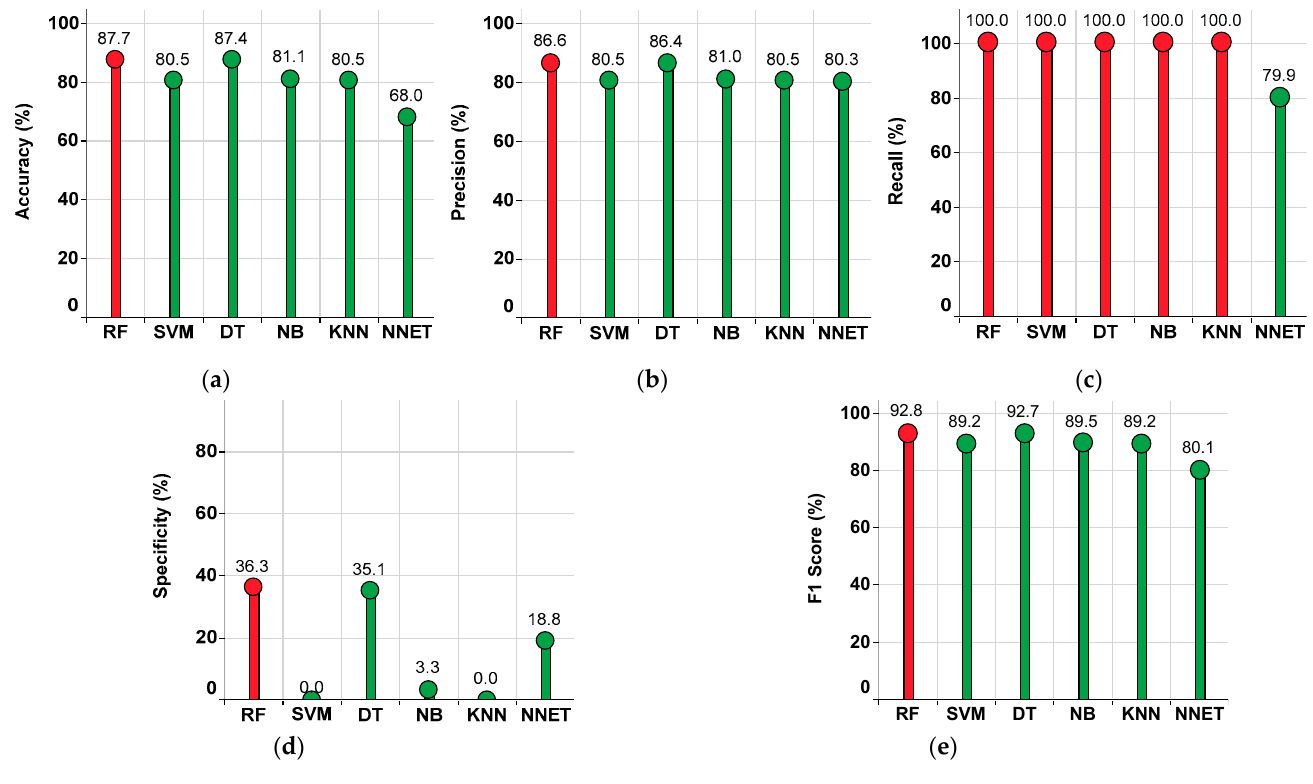
Figure 8. Performance metrics for the single-classifier approach on the KNN imputed dataset. ( a ) Accuracy. ( b ) Precision. ( c ) Recall. ( d ) Specificity. ( e ) F1 Score.